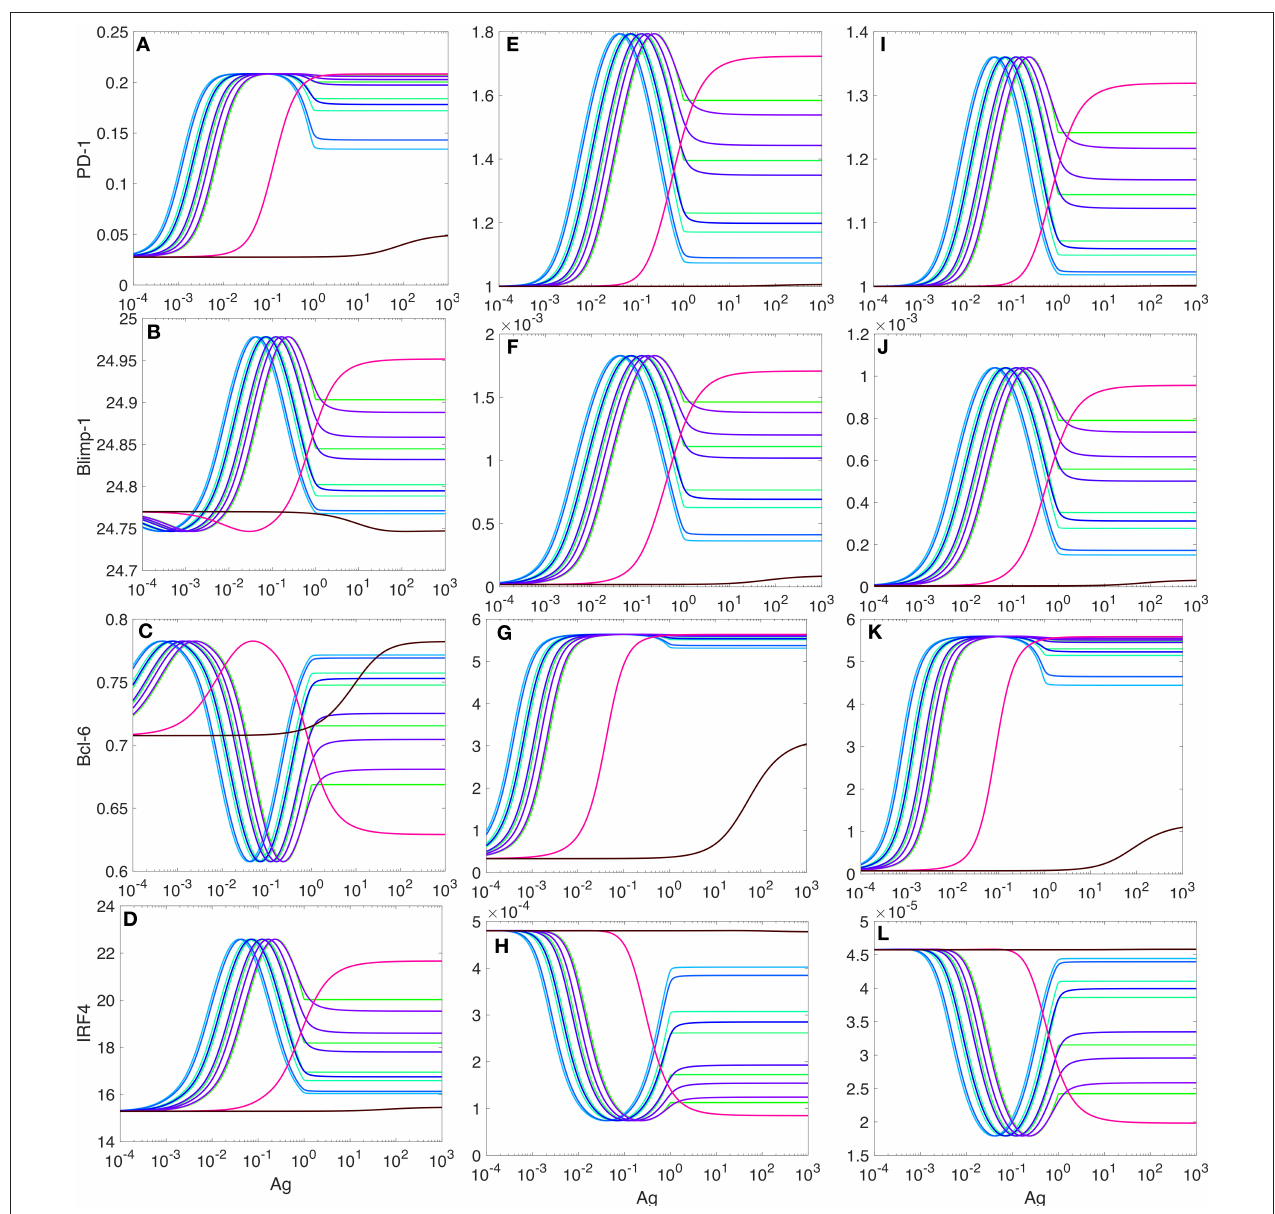
FIGURE 7 | PD-1 DIFFL responses in the presence of PD-1:PD-L1 interaction. (A–D) Correspond the case when 20% of PD-1 receptors are ligated with PD-L1. (E–H) Correspond the case when 50% of PD-1 receptors are ligated with PD-L1. (I–L) correspond the case when 90% of PD-1 receptors are ligated with PD-L1. All other explanations are provided in the legend for Figure 5